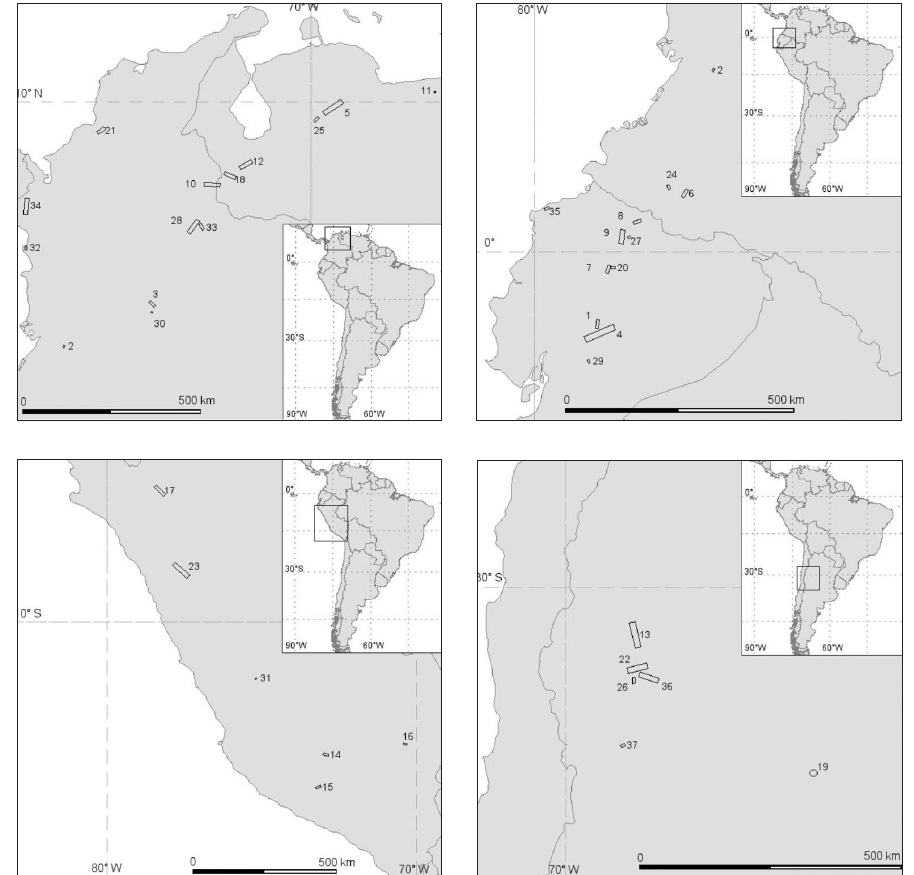
Fig. 3. Location of 37 intensity-based sources (box) quoted in table V. The adjacent number to each box cor- responds to ID_Box (table first